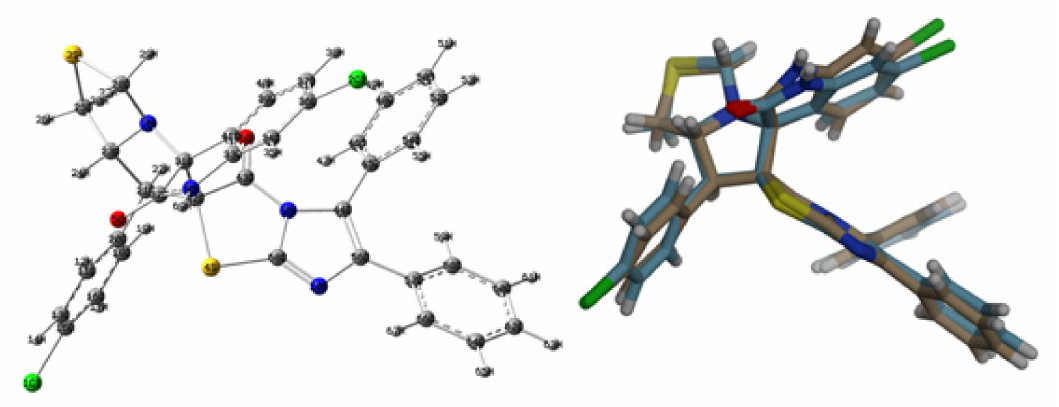
Figure 8. The calculated geometry using a B3LYP method ( left ) and its overlay with an experimental one ( right ) for 4